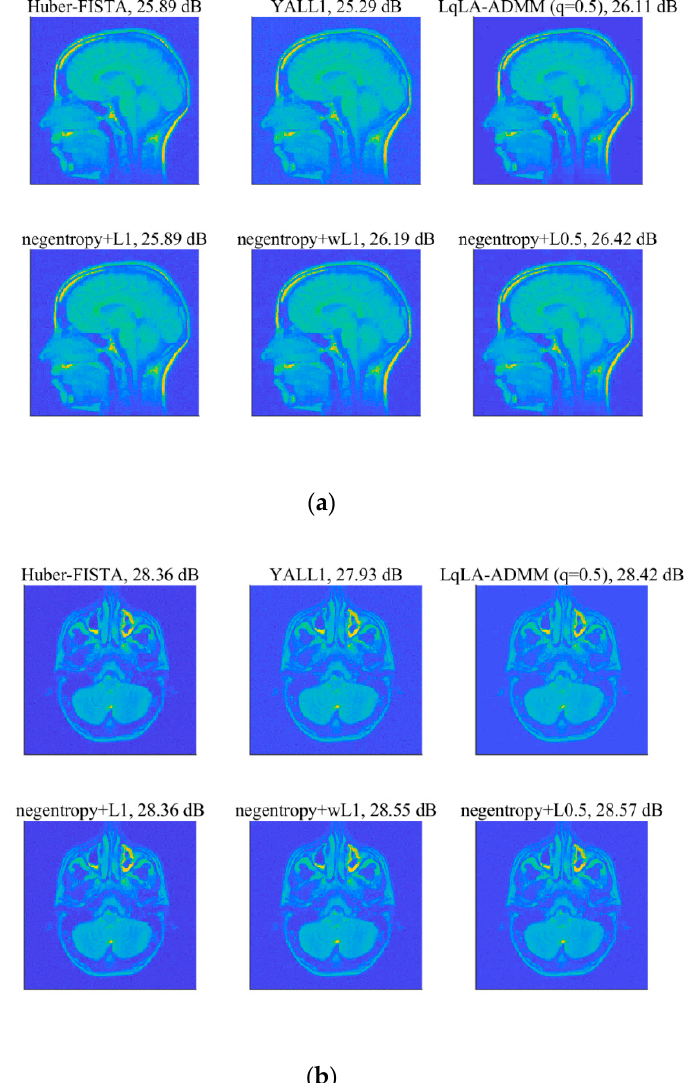
Figure 13. Recovery results of MRI images with the GMM noise: ( a ) brain MRI.; ( b ) sinusitis MRI.